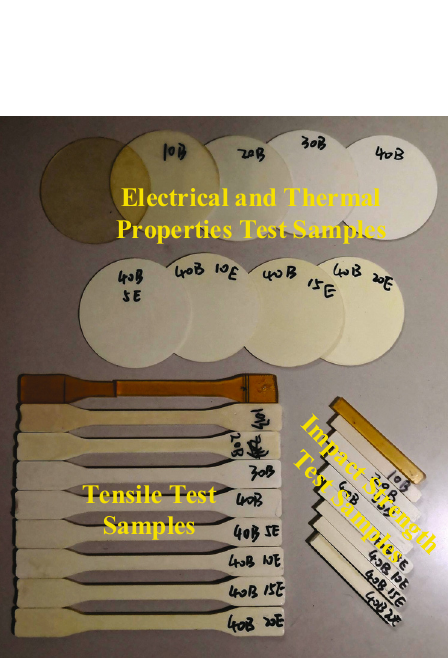
Tensile Test Samples